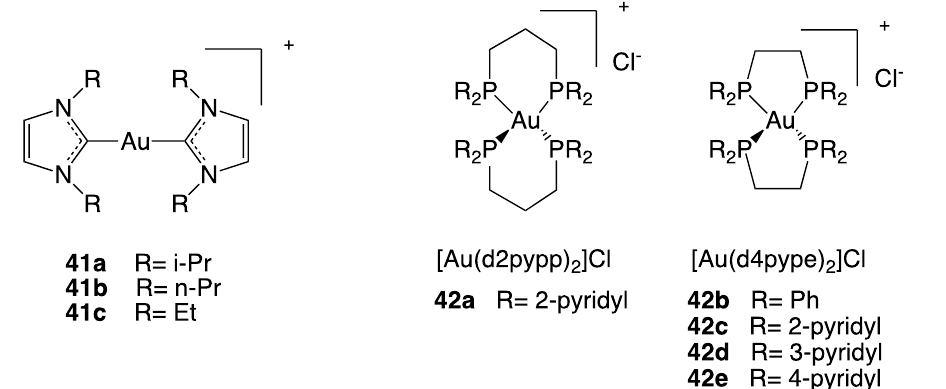
Figure 23. Structures of complexes 41a – c and 42a – e .